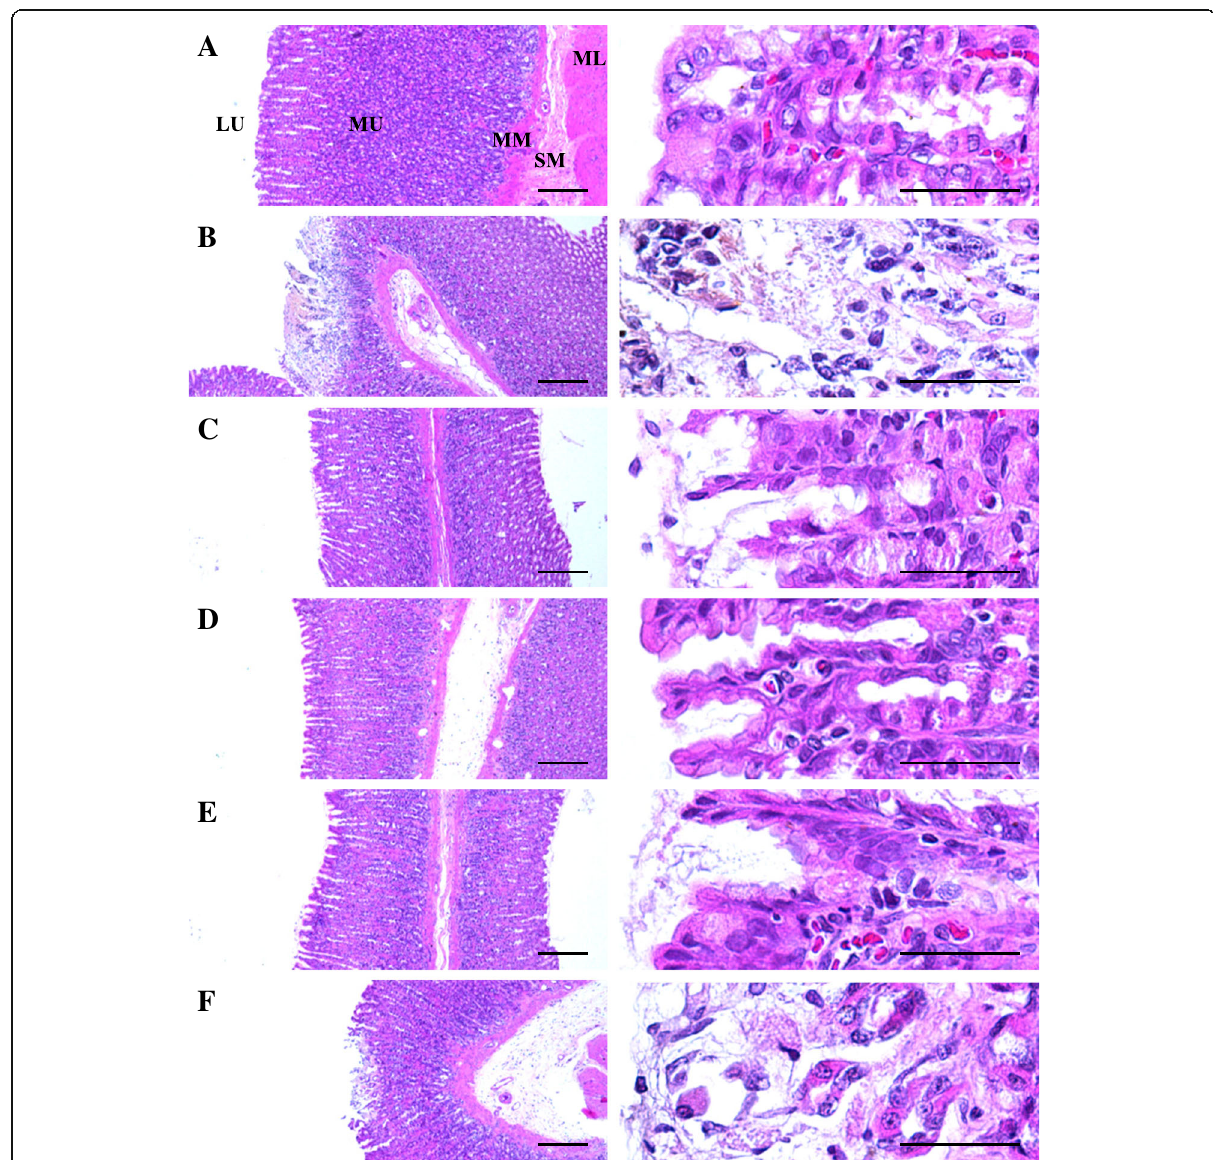
Fig. 5 Representative histological images of the fundic mucosa, taken from intact or IND-treated rats. a : Intact control (DW 5 mg kg − 1 , twice administrated rats with 30 min-intervals). b : IND control (DW 5 mg kg − 1 and IND 25 mg kg − 1 administered gastric mucosal damage